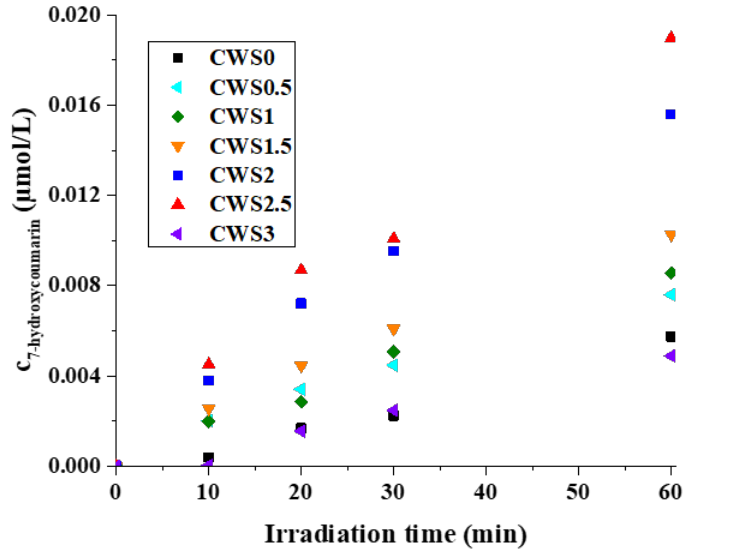
Figure 7. Production kinetics of 7-hydroxycoumarin from coumarin in the case of CWSX samples.